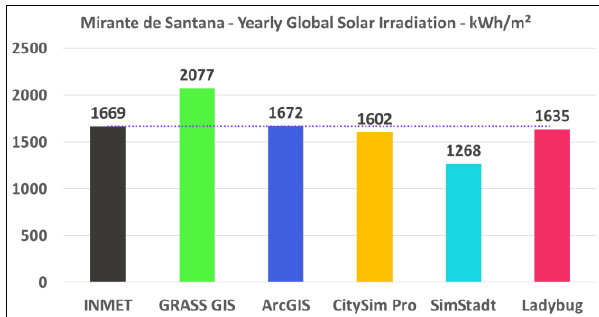
Figure 8. Yearly global solar irradiation values from the simulation tools and the meteorological station (INMET). Purple dot line is the reference annual